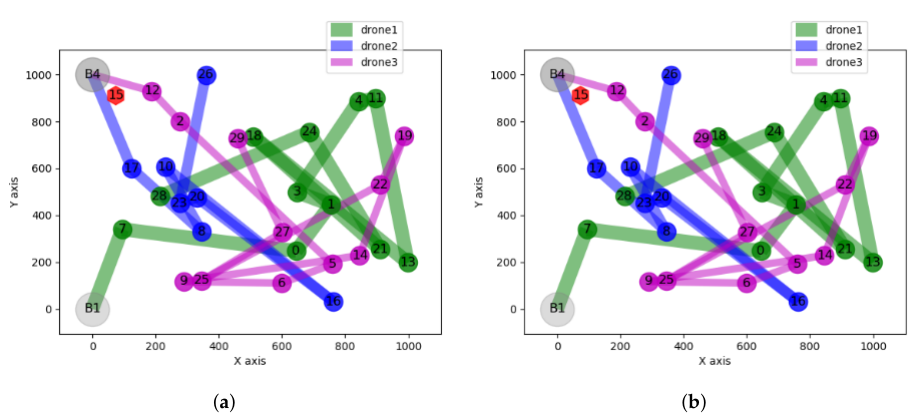
Figure 17. Next two visitations. ( a ) Third visitation; ( b ) Fourth visitation.